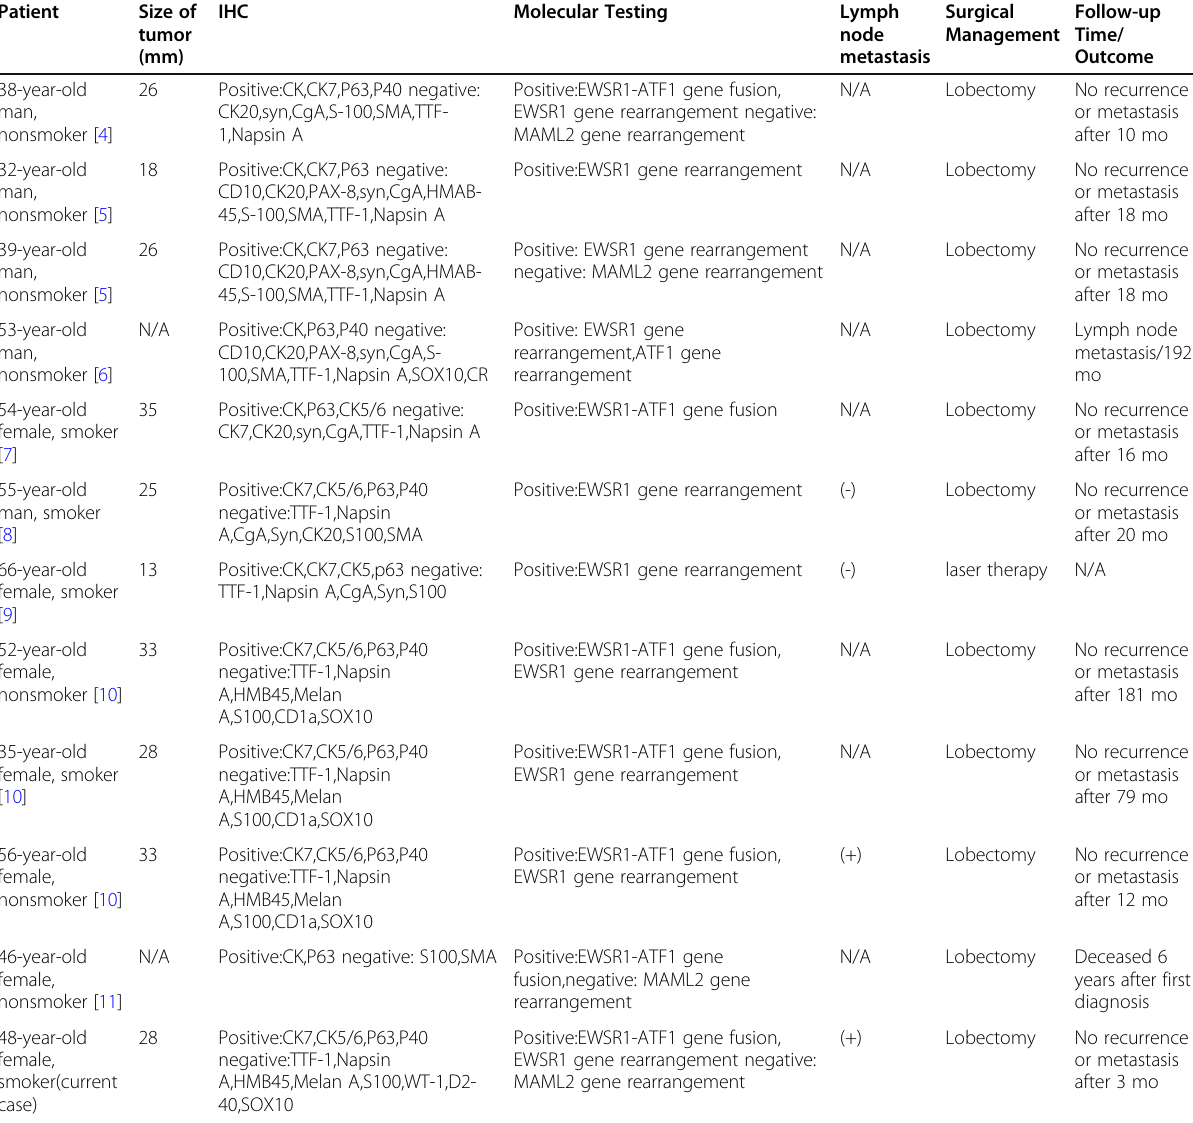
Table 1 Summary of clinicopathologic features of all reported hyalinizing clear cell carcinomas of the lung